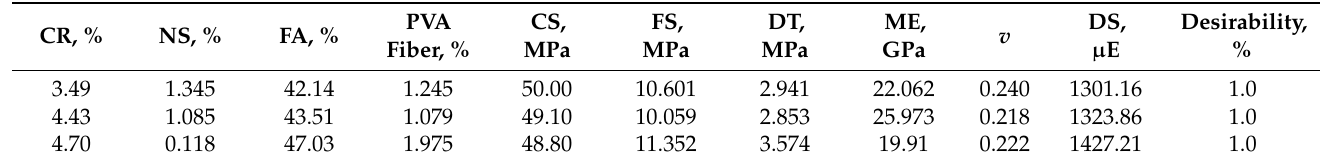
Table 9. Optimized rubberized ECC mixtures.